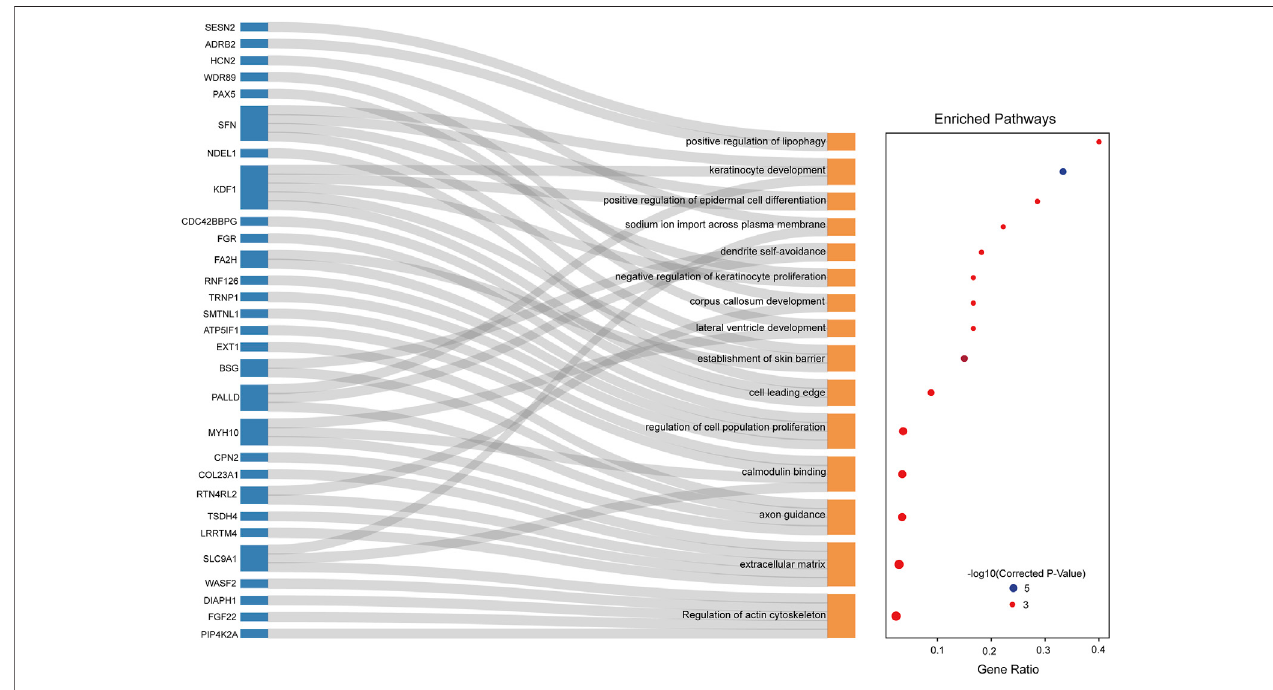
FIGURE 5 | KEGG and GO enrichment analysis of Xiangxi cattle candidate genes overlapped by F ST and XP-EHH methods (corrected p -value <